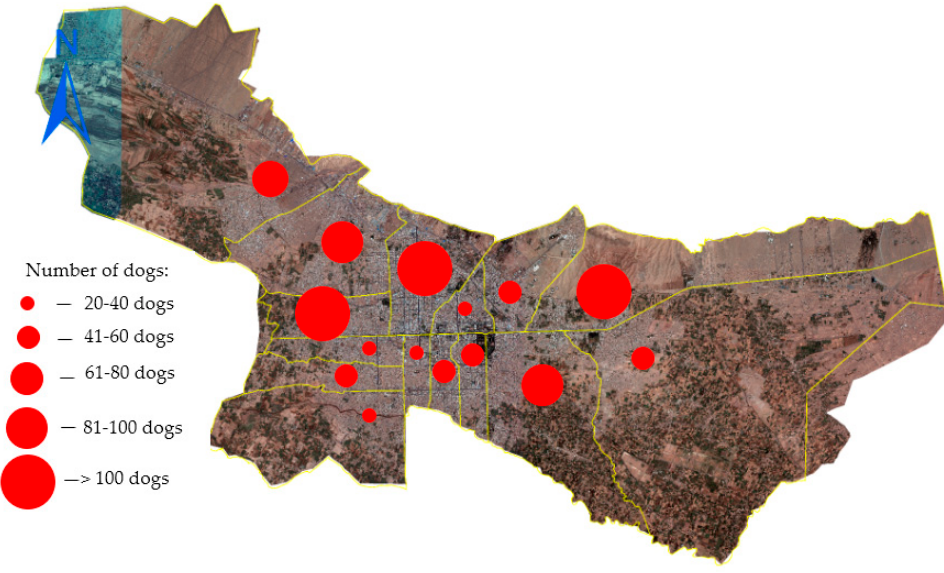
Figure 3. Total number of identified FRDs in 15 districts of Herat city during the survey period.